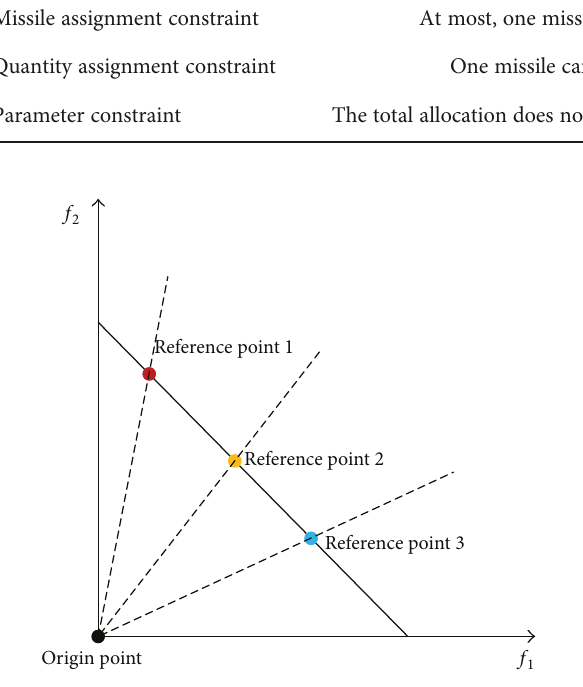
Figure 2: Three reference points are shown on a normalized reference line for a two-objective